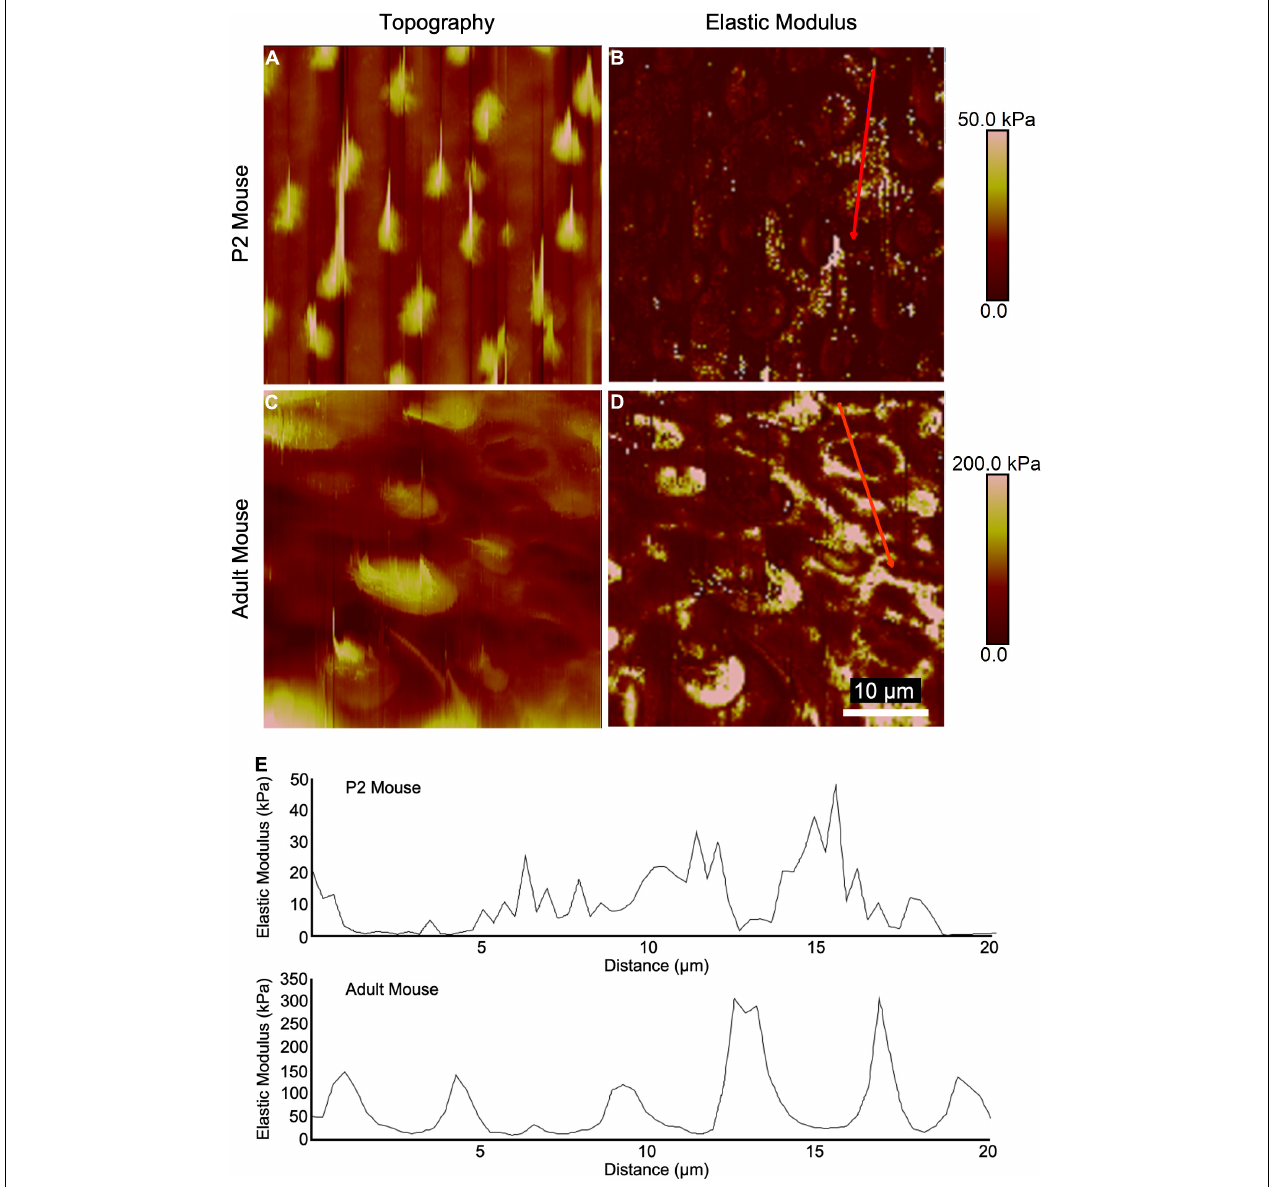
FIGURE 2 | High-resolution AFM measurements of utricular sensory epithelia from neonatal and adult mice show elevated stiffness at intercellular junctions. (A,C) Topography mapping of the utricular surface from P2 and adult mice reveals locations of hair bundles. (B,D) Elastic modulus mapping of the utricular surface shows elevated stiffnesses in regions corresponding to HC cuticular plates and intercellular junctions. (E) Line scans depicting elastic modulus along the red traces in (B,D) .